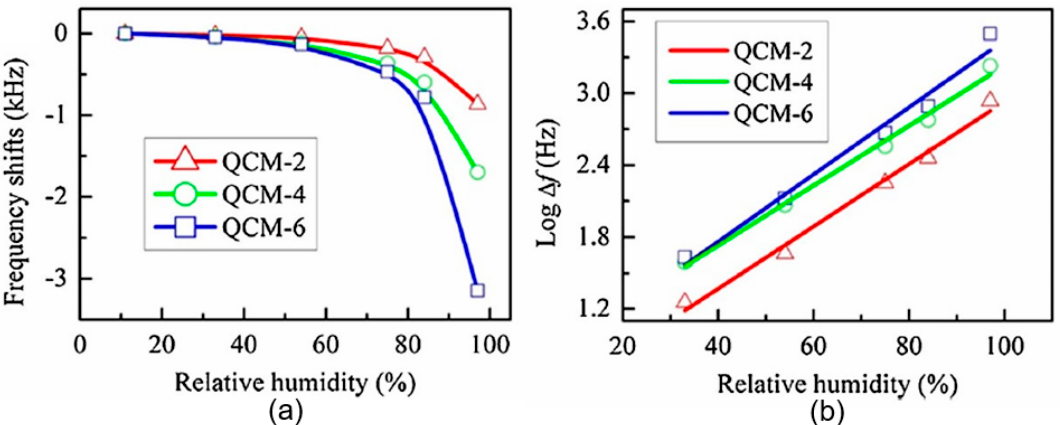
Figure 11. ( a ) The frequency response of the black phosphorous based QCM humidity sensors as a function of humidity; ( b ) the logarithmic fitting curve of Log ( ∆ f) versus humidity for all the sensors. QCM-2, QCM-4 and QCM-6 indicates sensors with 2, 4, and 6 µ L of BP nanosheets deposited on the electrode of QCMs. Reproduced with permission from Ref. [115]. Copyright Elsevier, 2017.